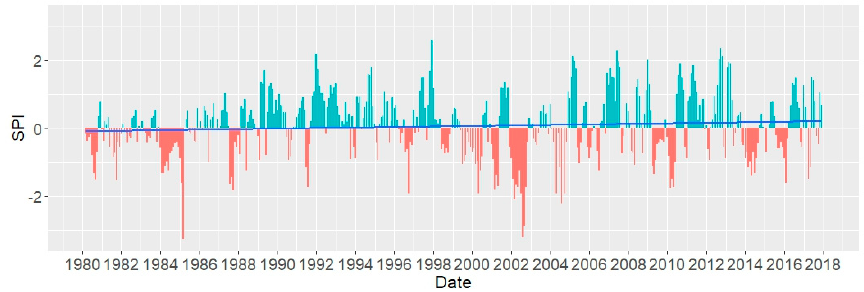
Figure 11. Three-month SPI of the Sibbi station.